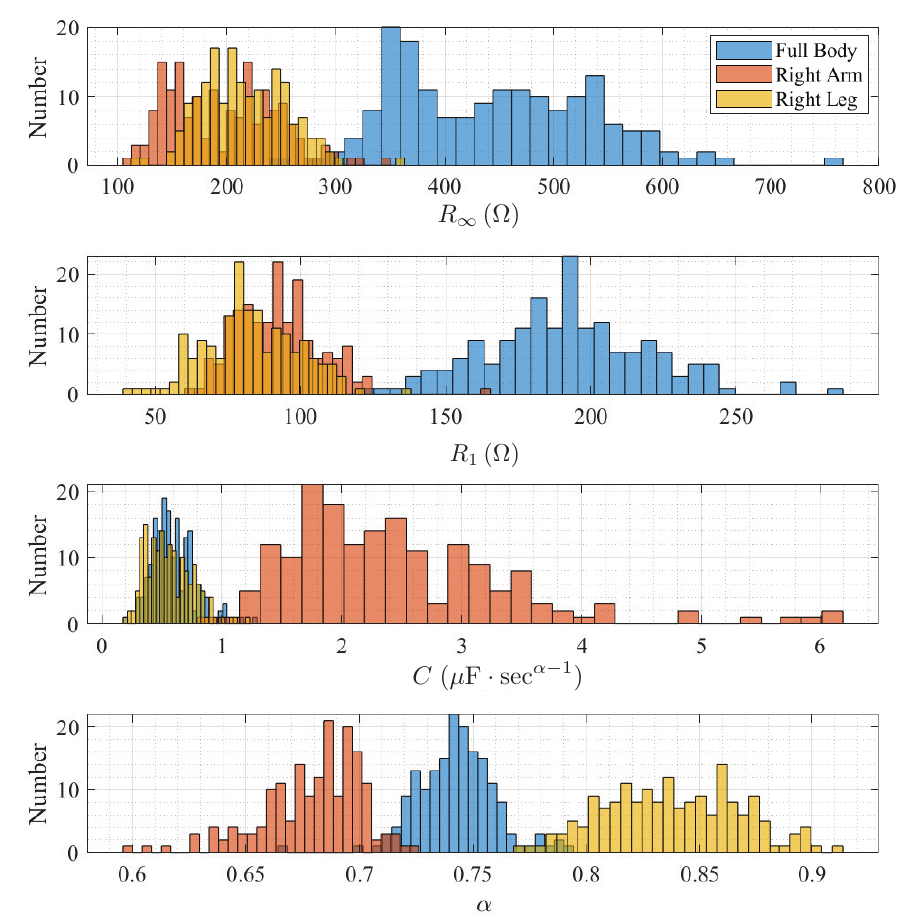
Figure 6. Histograms of the Cole-impedance model parameters ( R ∞ , R 1 , C , α ) identified by the PSO to best-fit the participant right-side full body (blue), right arm (orange), and right leg (yellow)